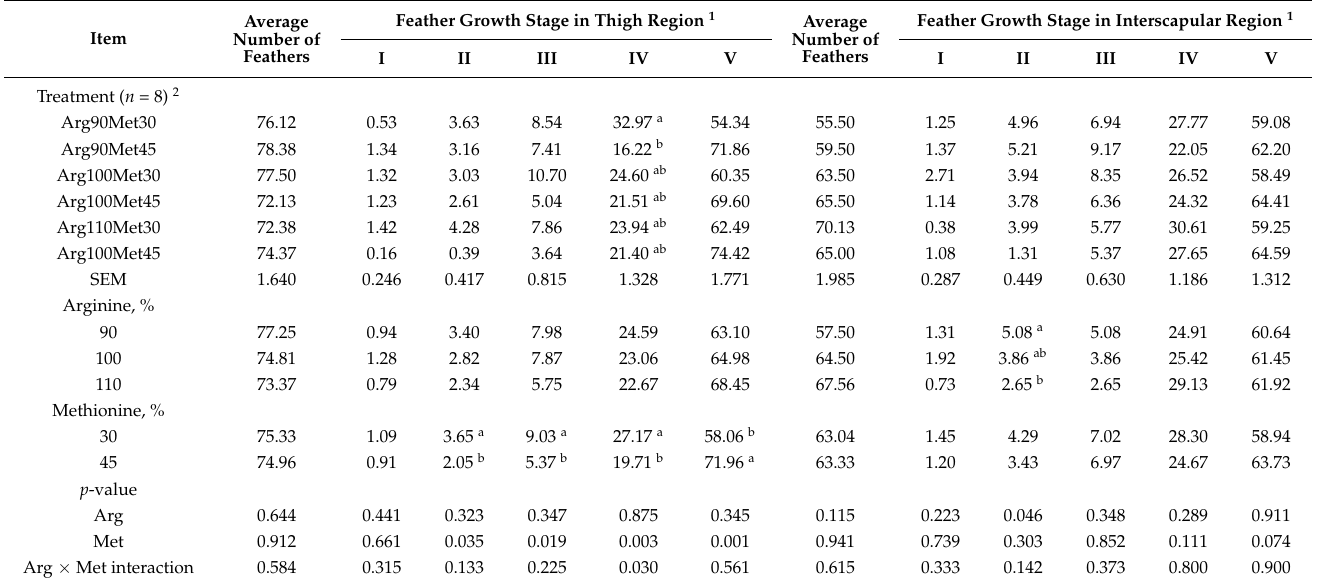
Table 3. Proportions of thigh and interscapular feathers (separately) in different growth stages in 16-week-old